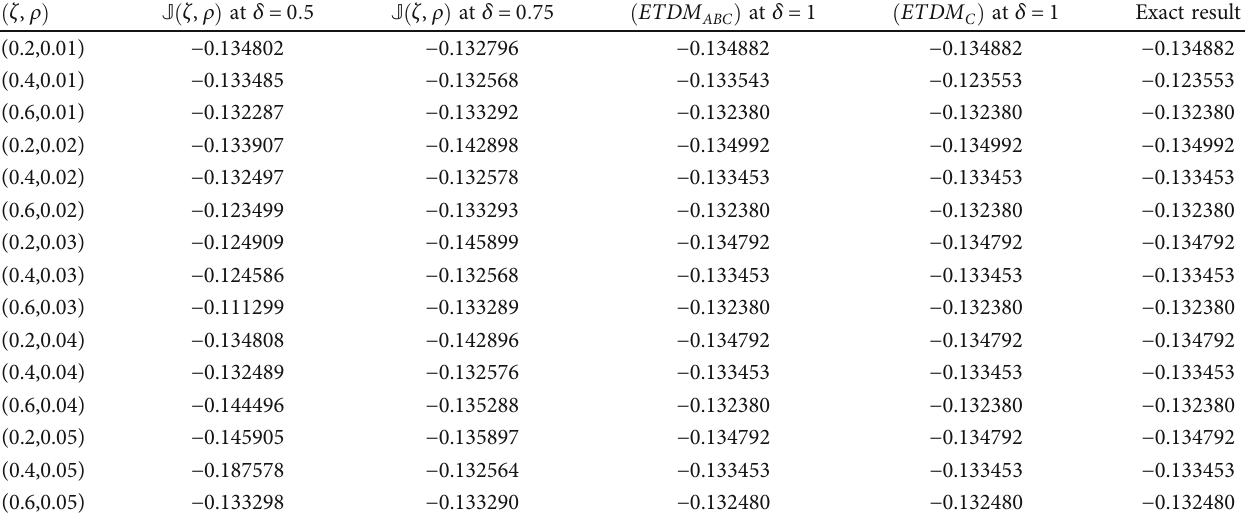
Table 3: Proposed method solution for J ð ζ , ρ Þ at di ff erent fractional orders of problem